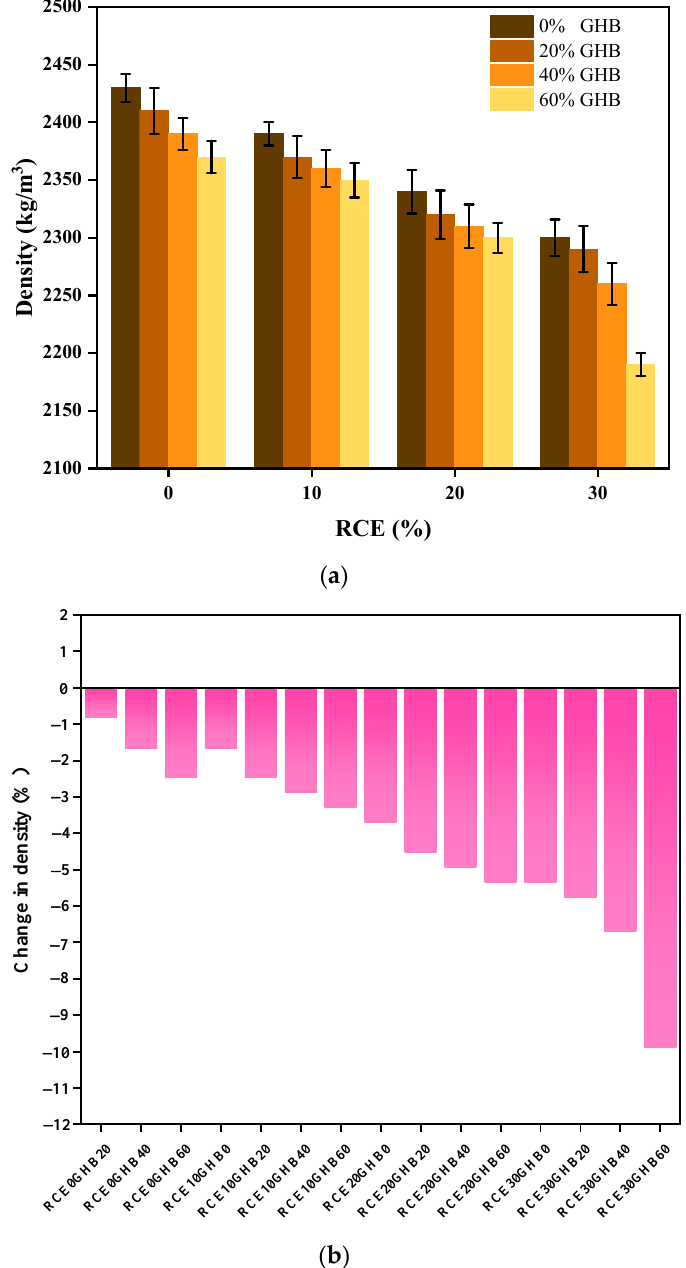
Figure 7. The experimental results and changes of density subject to the coupling influence between GHB and RCE on RTIC. ( a ) The experimental results of density on concrete; ( b ) the changes of density on fresh concrete.